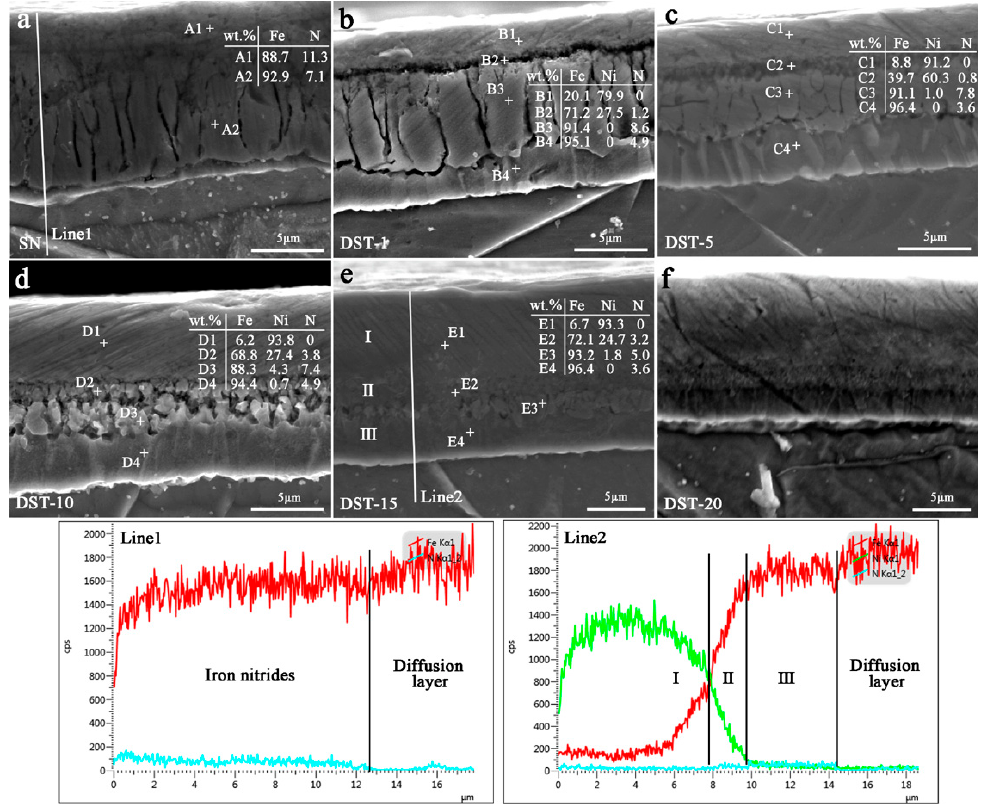
Figure 5. High magnification morphology, EDS element points, and lines of the surface layer on the SN sample ( a ) and DST samples ( b – f ).